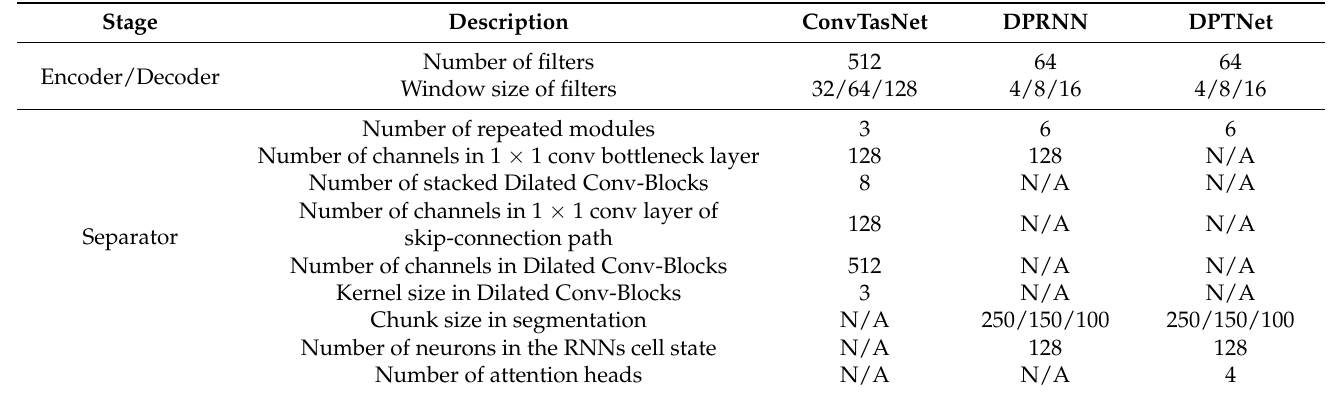
Table 1. Hyperparameters of three networks in our experiments, where “N/A” indicates this parameter is not used in this